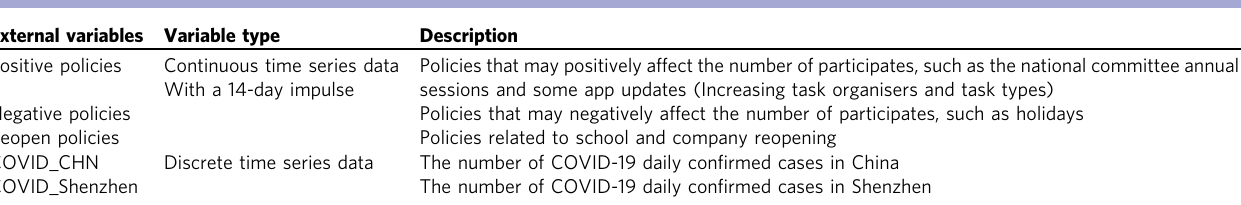
Table 2 Descriptions of external variables that may affect volunteer